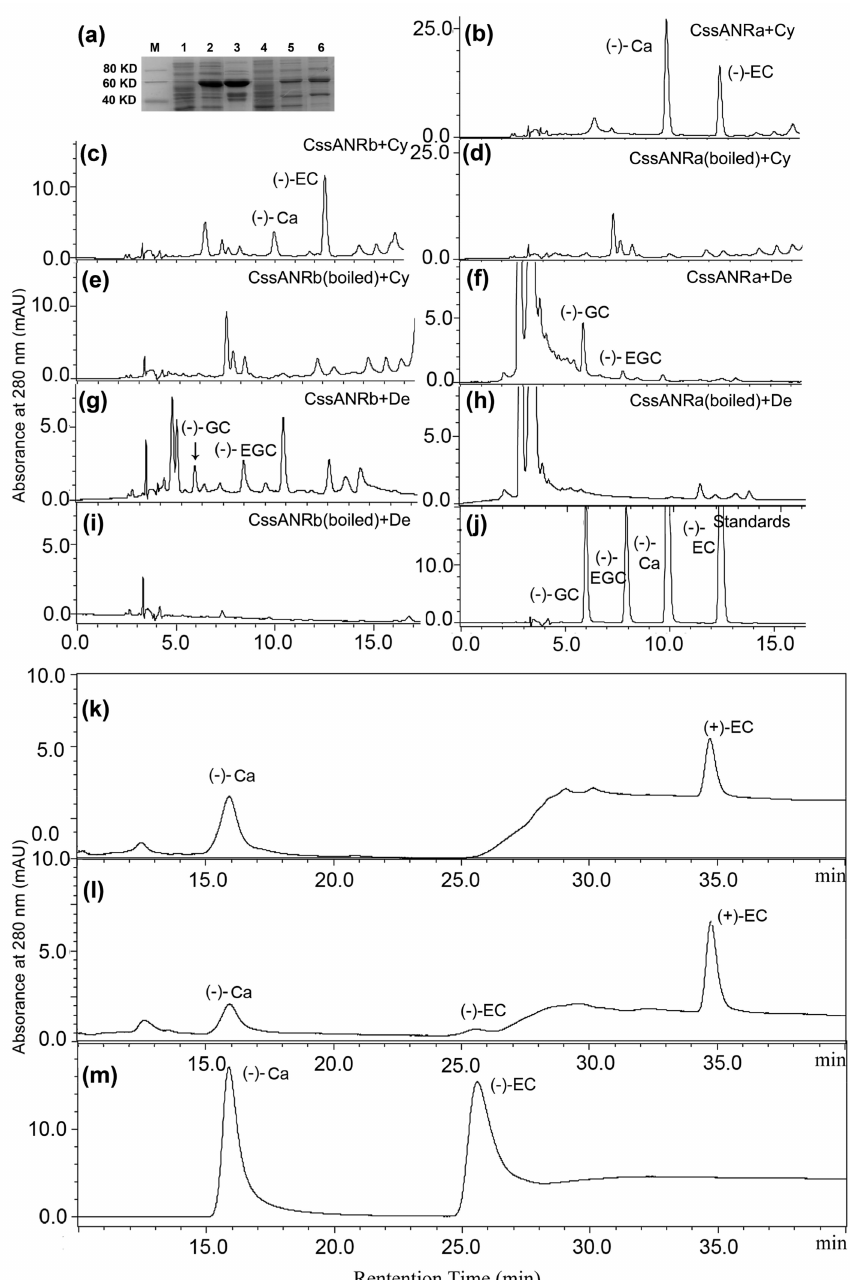
Figure 6. Enzymatic analysis of recombinant CssANRa and CssANRb. ( a ) SDS-PAGE shows induction of recombinant pET31a + -CssANRa and T7 SUMO-CssANRb induced in E. coli , M: molecular weight markers, 1: protein profile prior to induction of pET31a + -CssANRa, 2: protein profile after induction of pET31a + -CssANRa for 3 h, 3: partially purification of supernatant of pET31a + -CssANRa, 4: prior to induction of T7 SUMO-CssANRb, 5: after induction of T7 SUMO-CssANRb for 3 h, 6: partially purification of supernatant T7 SUMO-CssANRb; ( b – e ) HPLC profiles show the formation of ( − )-catechin [( − )-Ca] and ( − )-epicatechin [( − )-EC] produced from incubations of cyanidin with recombinant CssANRa ( b ) and CssANRb ( c ) but not boiled CssANRa ( d ) and CssANRb ( e ); ( f – i ) HPLC profiles show the formation of ( − )-gallocatechin [( − )-GC] ( f ) and ( − )-epigallocatechin [( − )-EGC] produced from incubations of delphinidin with recombinant CssANRa ( g ) and CssANRb ( h ) but not boiled CssANRa ( i ) and CssANRb ( j ). ( k ), profiles of ( − )-Ca, ( − )-EC,( − )-GC, and ( − )-EGC standards. ( k – m ), normal-phase chiral column based separation shows ( − )-Ca and (+)-EC from CssANRa ( k ), ( − )-Ca, ( − )-EC, and (+)-EC from CssANRb ( l ) after incubation with cyanidin, and ( − )-Ca and ( − )-EC standards ( m